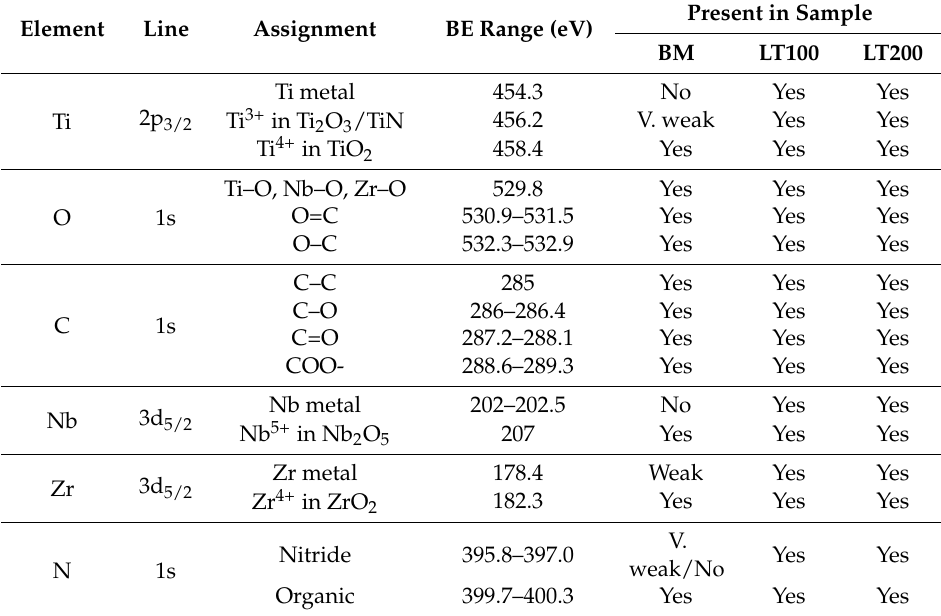
Table 2. Summary of the chemical species detected by